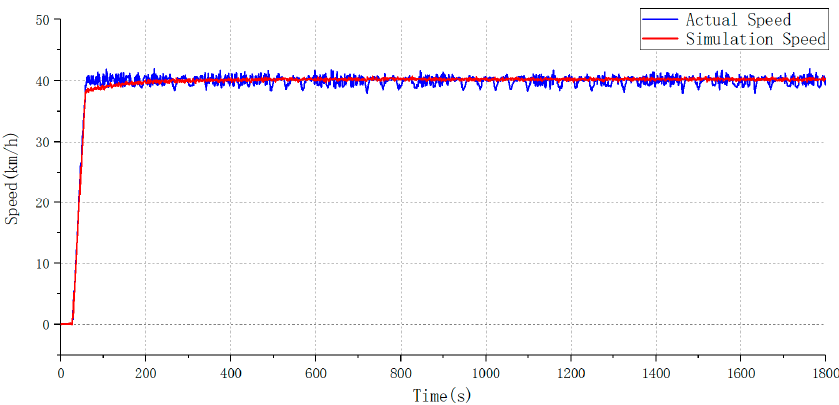
Figure 13. Simulated vehicle speed and actual vehicle speed result graph.